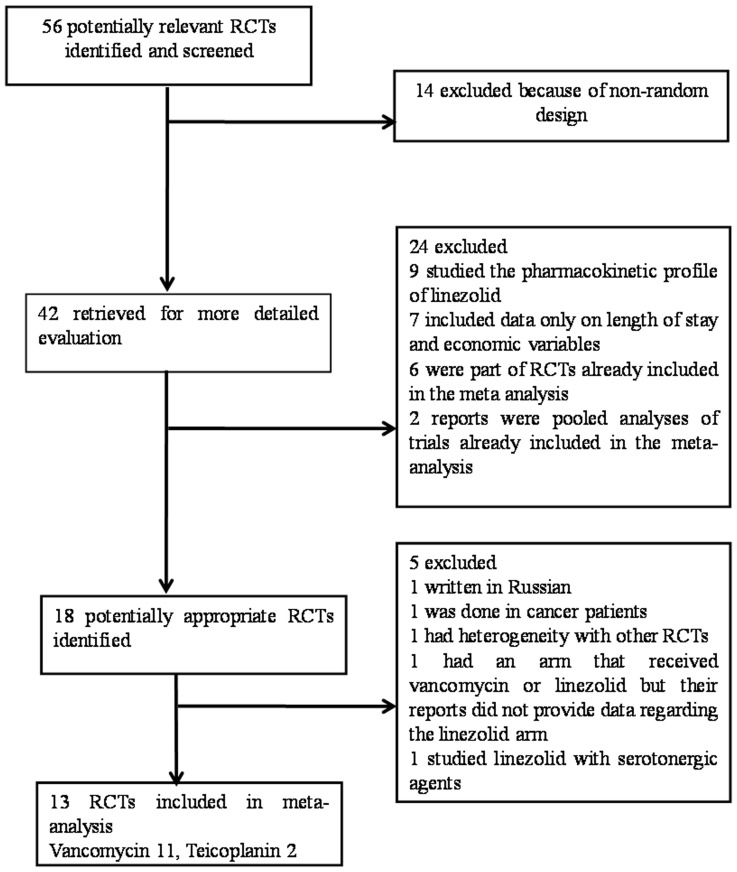
Flow diagram of the randomized controlled trials (RCTs) for meta-analysis.